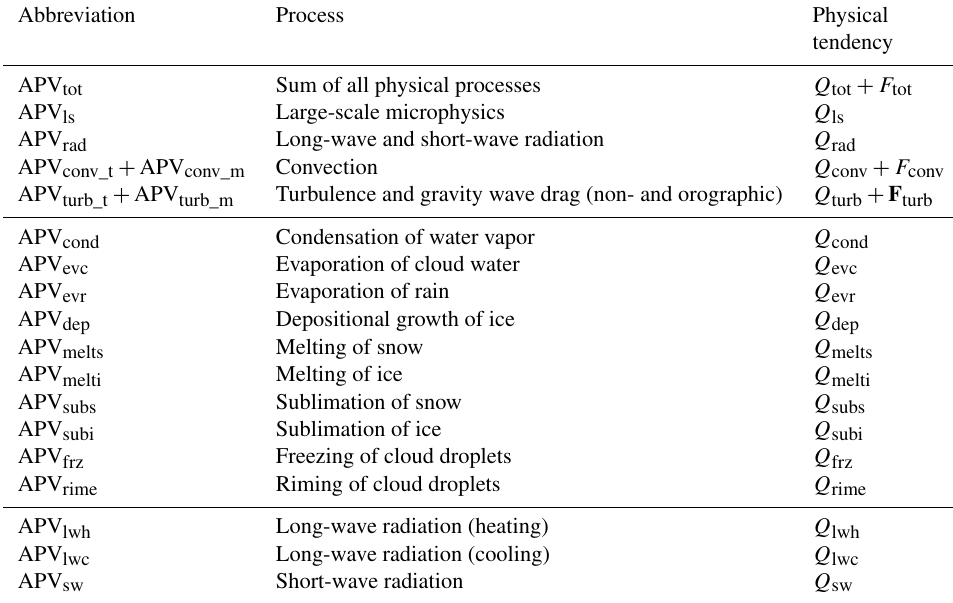
Table 1. Abbreviations and description of the diabatic processes considered in this study. Abbreviation